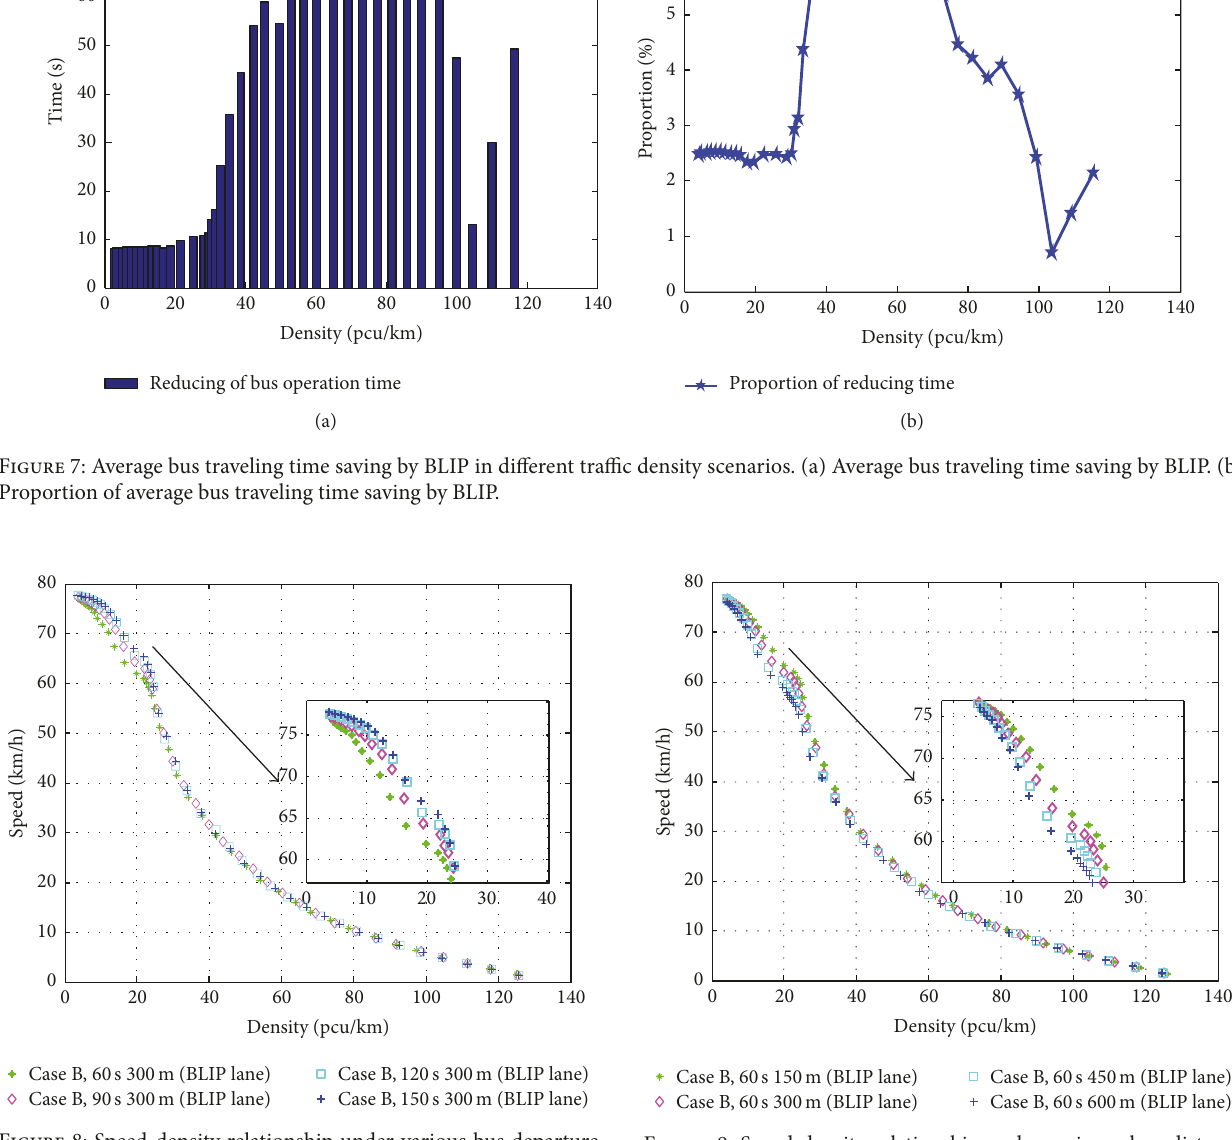
Figure 9: Speed-density relationship under various clear distance